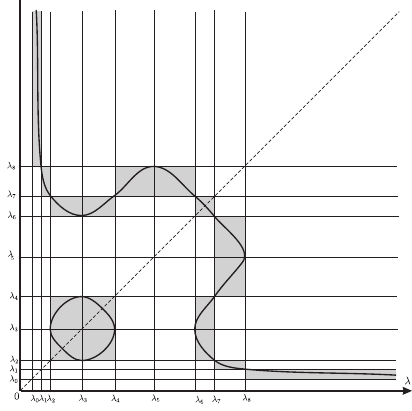
Figure 4. Schematical view of subset F ± 1 . The union of D i × D j for full couples ( i ; j ) is